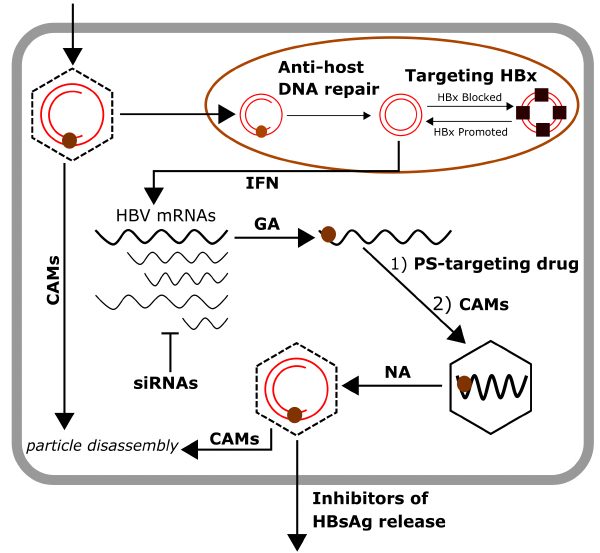
Figure 2. Current and potential future drugs for the treatment of HBV. The different types of drugs are labelled next to the viral life cycle steps they target. Capsid assembly modulators (CAMs) both inhibit nucleocapsid assembly and promote disassembly of mature nucleocapsids, either following entry or prior to release, and are therefore indicated at multiple steps of the viral life cycle. Interferon (IFN)-based therapy blocks the transcription step. Small interfering RNAs (siRNAs), which reduce mRNA levels, are indicated by the bar-headed line. Geldanamycin (GA) prevents the formation of the ribonucleoprotein (RNP) complex. Nucleot(s)ide analogues (NAs) inhibit the progression of immature into mature nucleocapsids. Packaging signal (PS)-targeting drugs bind to the PSs of HBV and inhibit nucleocapsid assembly. Inhibitors of HBsAg release target viral and subviral particle (SVP)